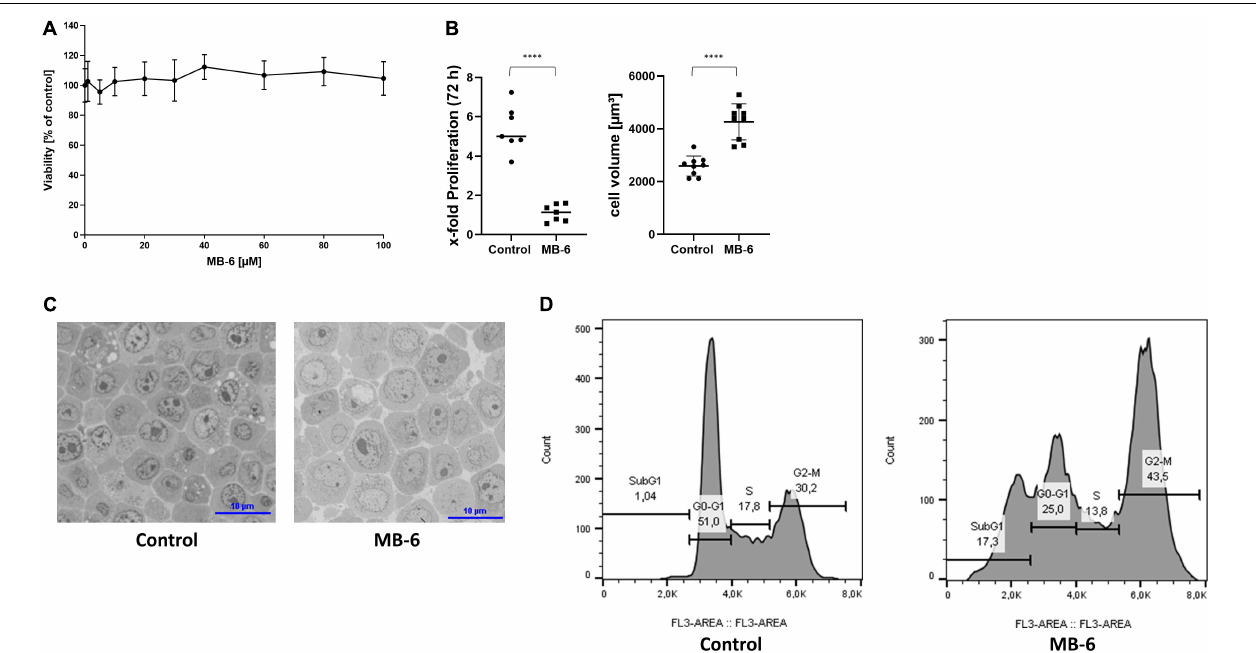
FIGURE 1 | MB-6 negatively affects McA-RH7777 cells in morphology and proliferation. (A) 24 h treatment of cells with MB-6 showed no signs of acute cytotoxicity in concentrations up to 100 µ M. Higher concentrations would result in crystallization of MB-6. (B) 72 h treatment of cells with 30 µ M MB-6 decreased cellular proliferation close to a complete proliferation arrest along with a near doubling in cell volume. (C) Micrographs from semi-thin sections of cells treated for 72 h with 30 µ M MB-6 demonstrate an increase in cellular volume as well as multiple and fragmented nuclei. Scale bars equal 10 µ m. (D) Cell cycle analysis of fixed cells reveals a strong increase in the SubG1 and G2-M cell population with a concomitant decrease in G1 population. **** p <